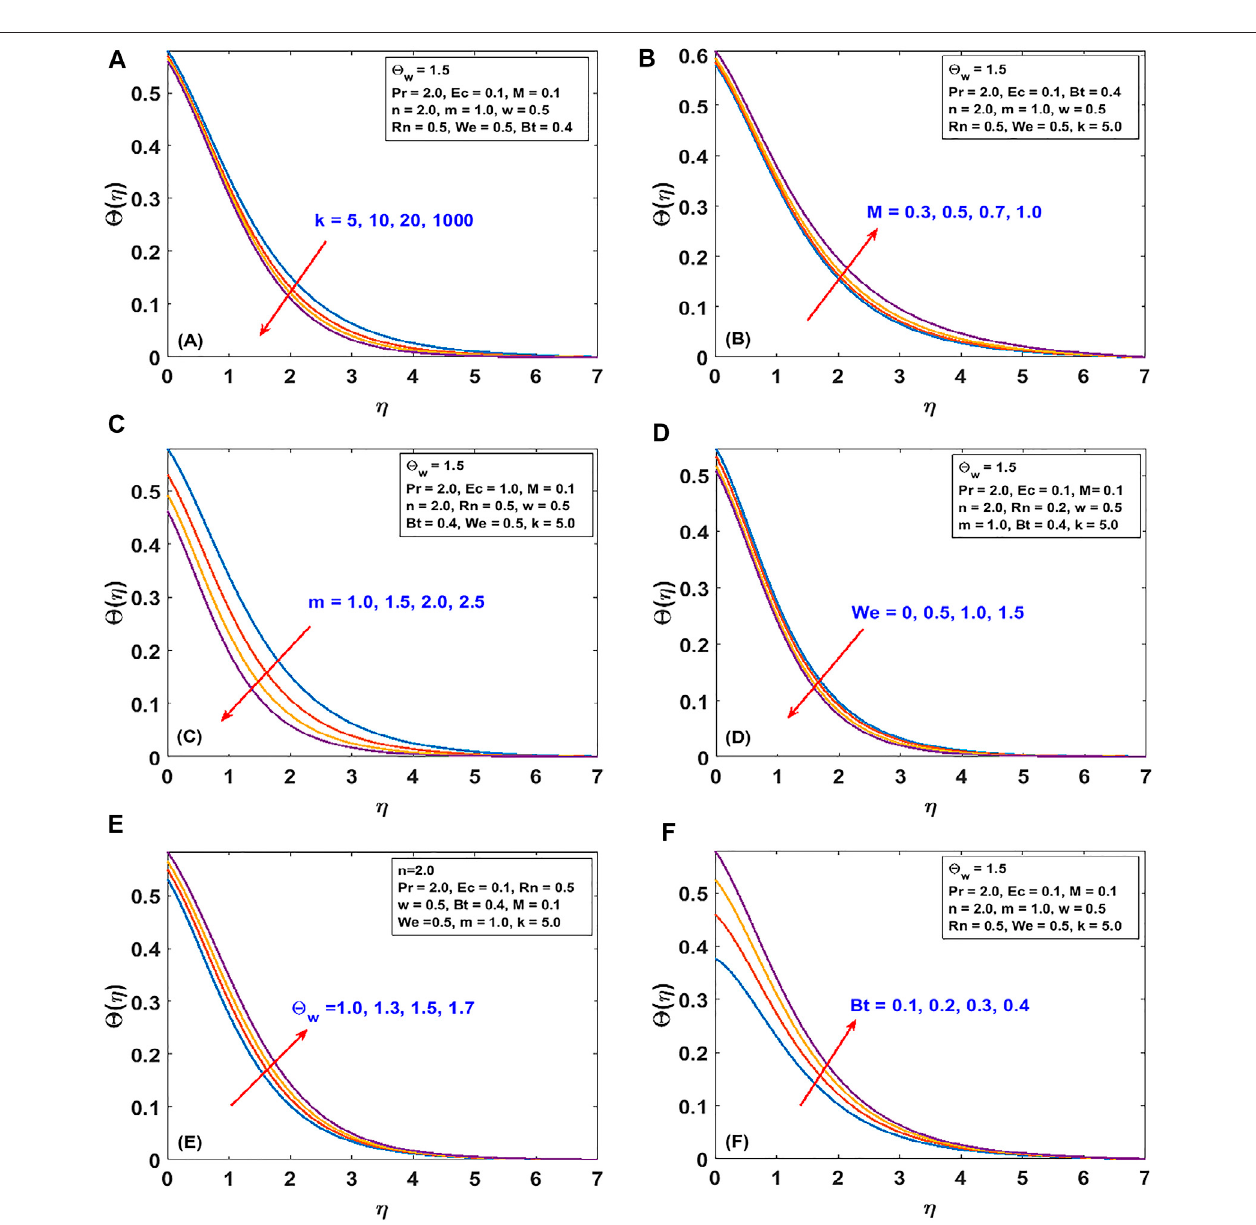
FIGURE 4 | Effect of k, M, m, We, Θ w , and Bt on temperature.